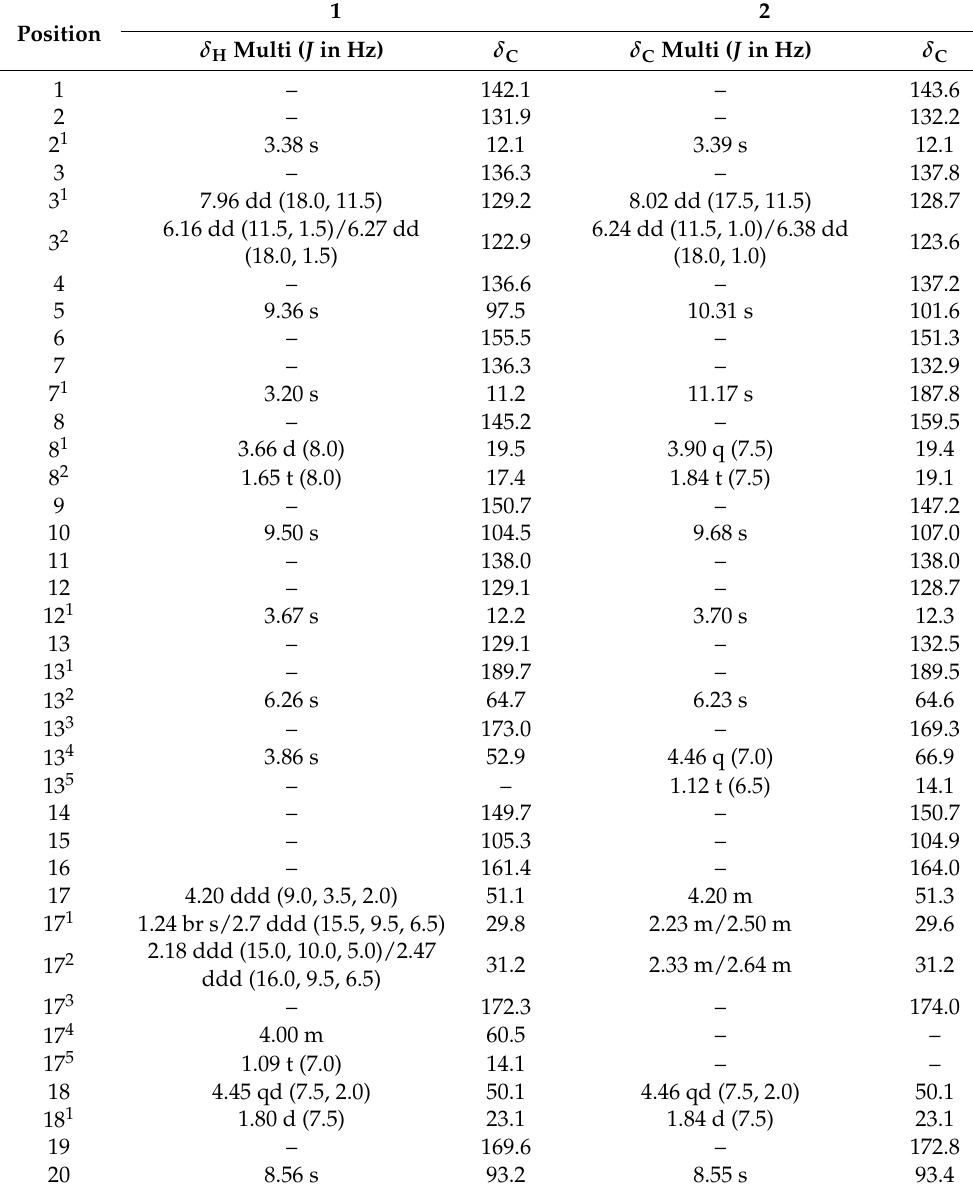
Table 1. 1 H and 13 C NMR spectroscopic data on compounds 1 and 2 ( δ in ppm, CDCl 3 , 500 and 125